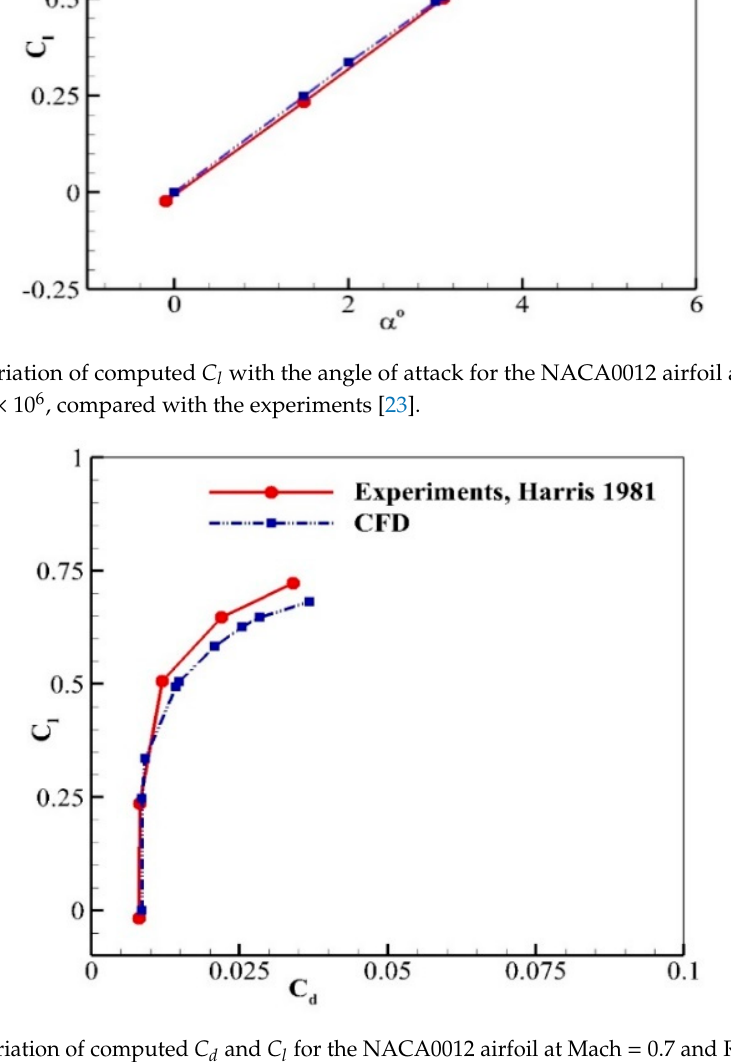
Figure 12. Variation of computed C d and C l for the NACA0012 airfoil at Mach = 0.7 and Re ∞ = 9 × 10 6 , compared with the experiments [23].